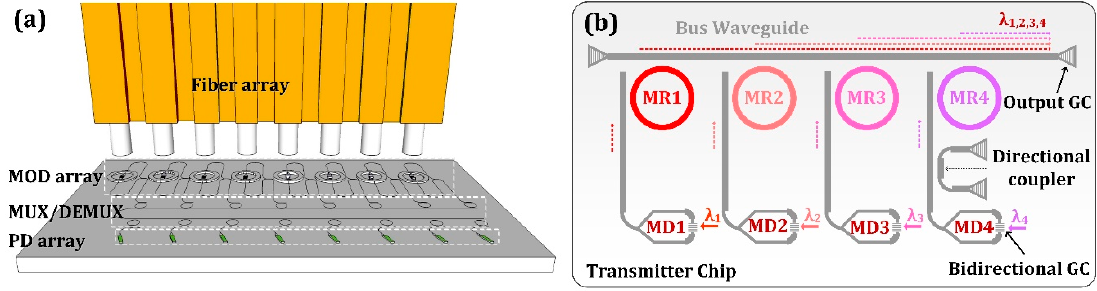
Figure 1. ( a ) Schematic diagram of the bidirectional grating coupler (BGC)-based wavelength-division-multiplex (WDM) optical interconnect tested with fiber array. ( b ) The schematic diagram of the proposed WDM transmitter.